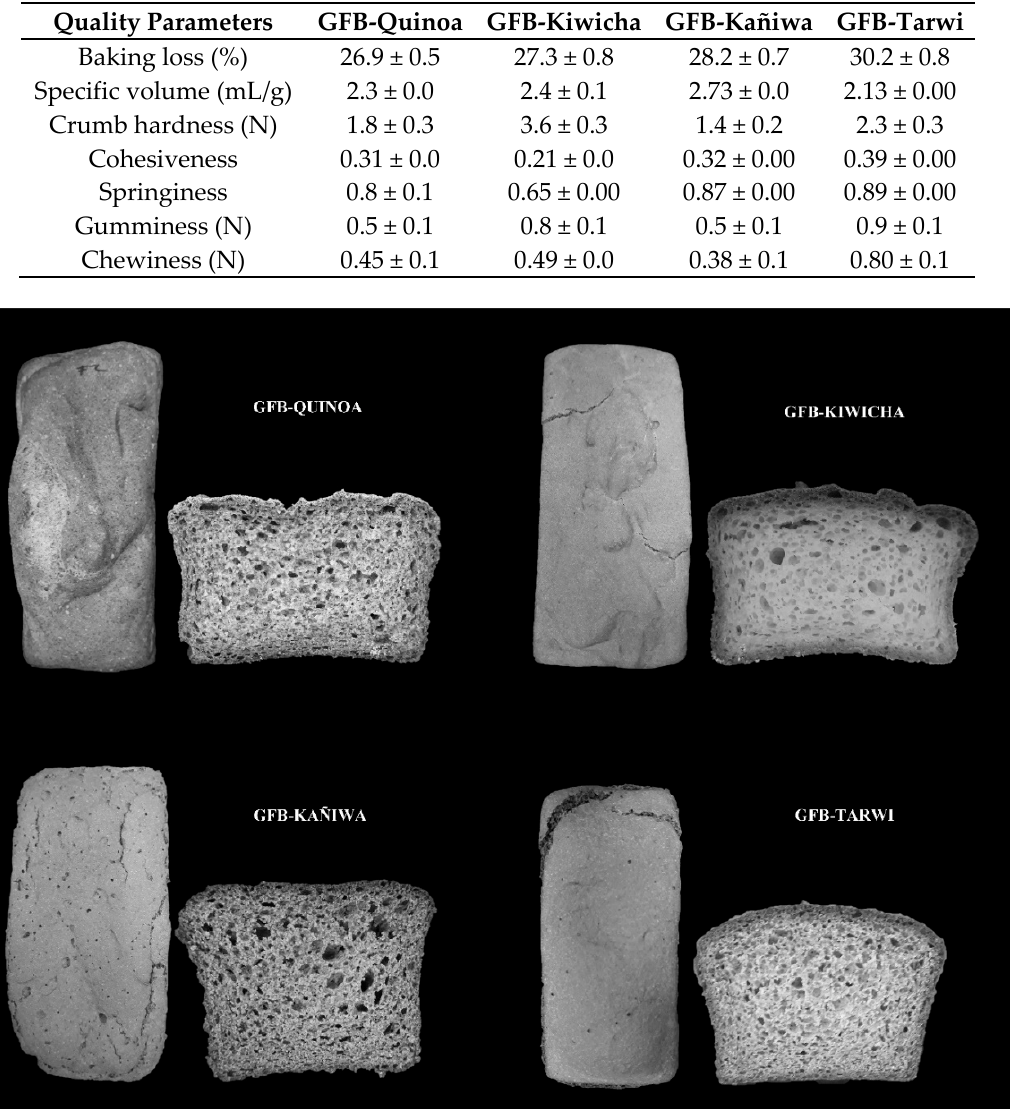
Table 1. Characteristics of gluten-free breads (GFB) made with Andean grains.